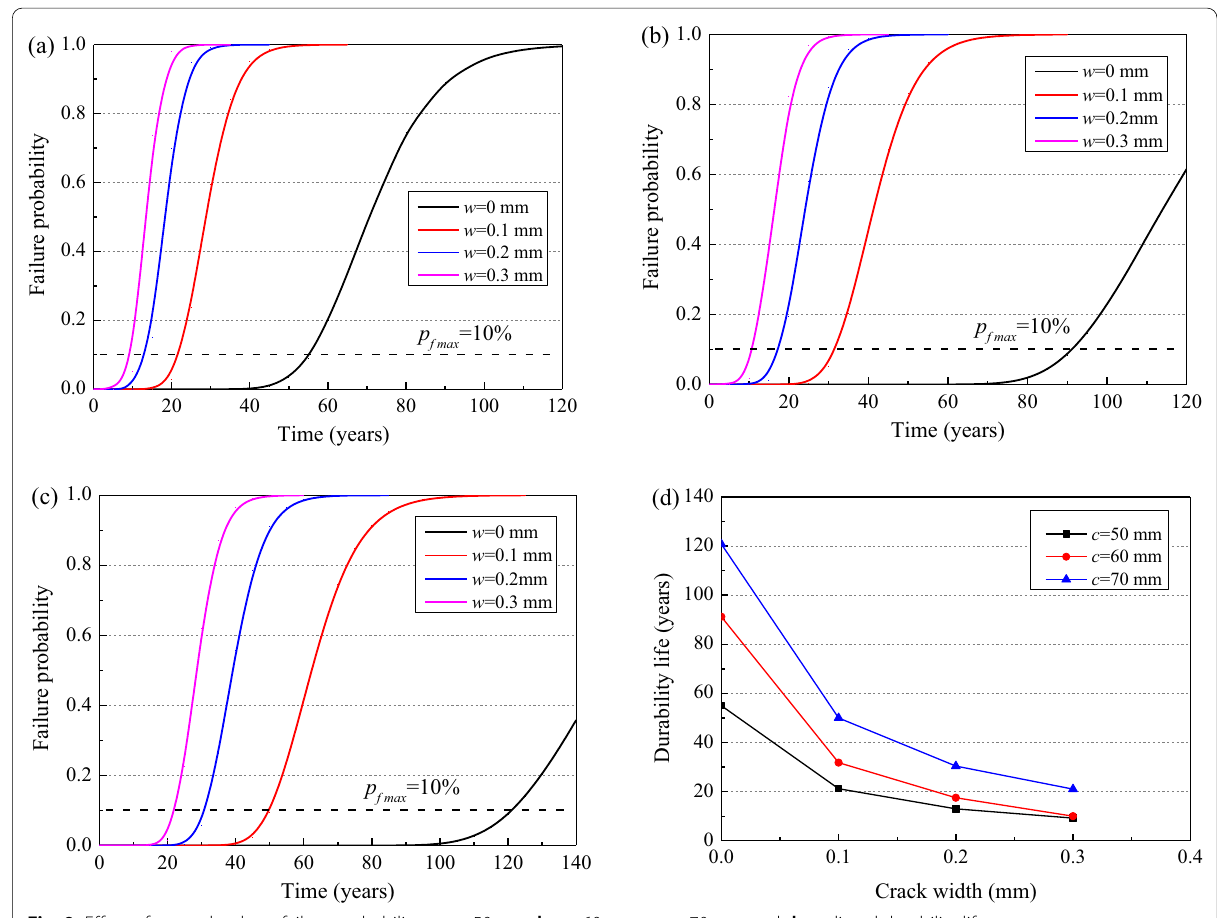
Fig. 9 Effect of cover depth on failure probability: a c